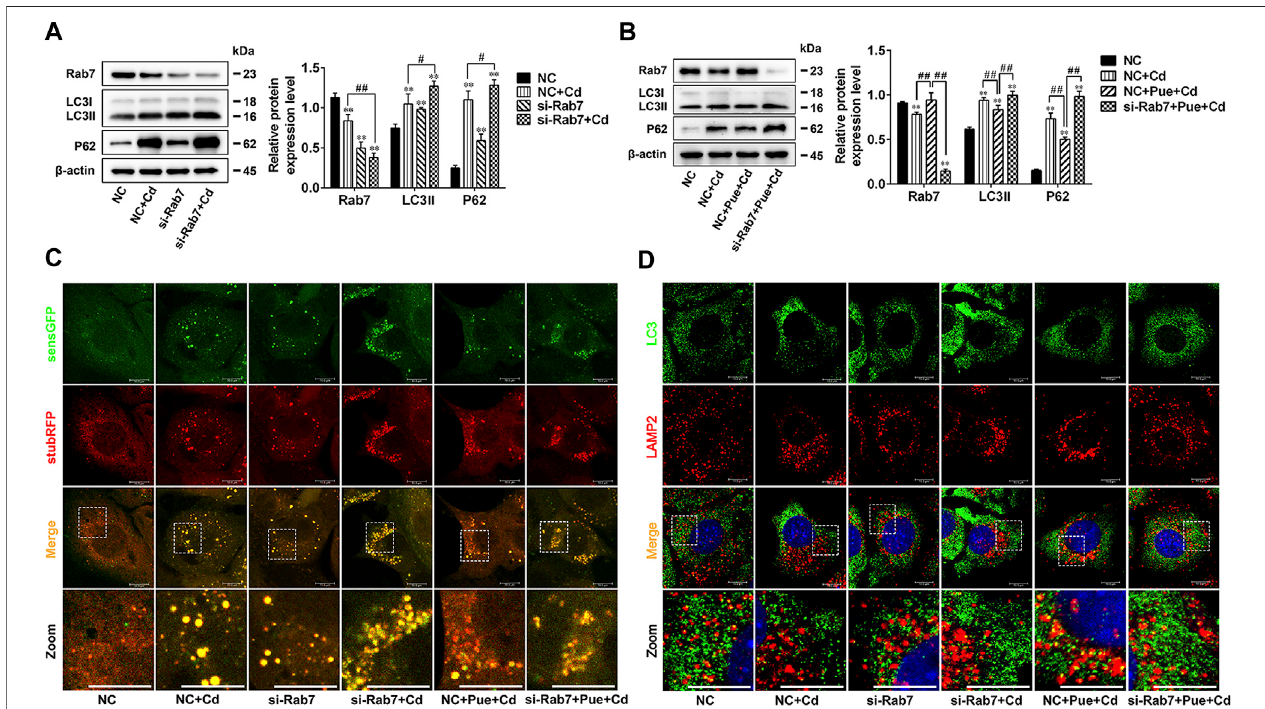
FIGURE6| Rab7played animportantroleinPue-alleviatedCd-induced autophagy blockadeinAML12cells.BasedontreatmentwithaRab7siRNAorNCsiRNA for 24 h. (A) Cells were treated with or without Cd for 12 h, (B) cells were treated with Pue and/or Cd for 12 h, and then the levels of Rab7, LC3, and P62 were analyzed using westernblotting.Dataareshownasthemean ± SD(n (cid:2) 3). Compared withtheNCgroup, ** p < 0.01.Compared withtheNC +CdgrouporNC+Pue+Cdgroup, # p < 0.05, ## p < 0.01. (C) CellsstablyexpressingstubRFP-sensGFP-LC3weretreatedwithRab7siRNAorNCsiRNAfor24 h,followedbytreatmentwithPueand/ or Cd for 12 h, and then the LC3 puncta were captured under a fl uorescence microscope. Representative images of LC3 puncta and their partial enlarged pictures are shown. Scale bar (cid:2) 10 μ m. (D) After treated with Rab7 siRNA or NC siRNA for 24 h, cells were treated with Pue and/or Cd for 12 h, and then the co-localization of LC3 with LAMP2 was analyzed using immuno fl uorescence staining. Representative pictures and their partial enlarged pictures are displayed. Scale bar (cid:2) 10 μ m.